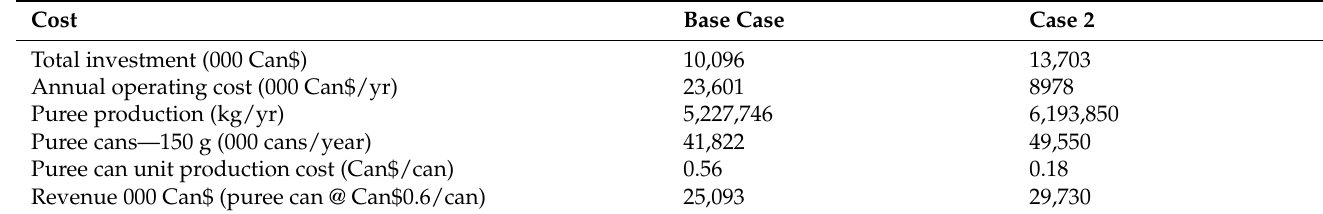
Table 2. Overall process economics of the puree production plant for two cases.